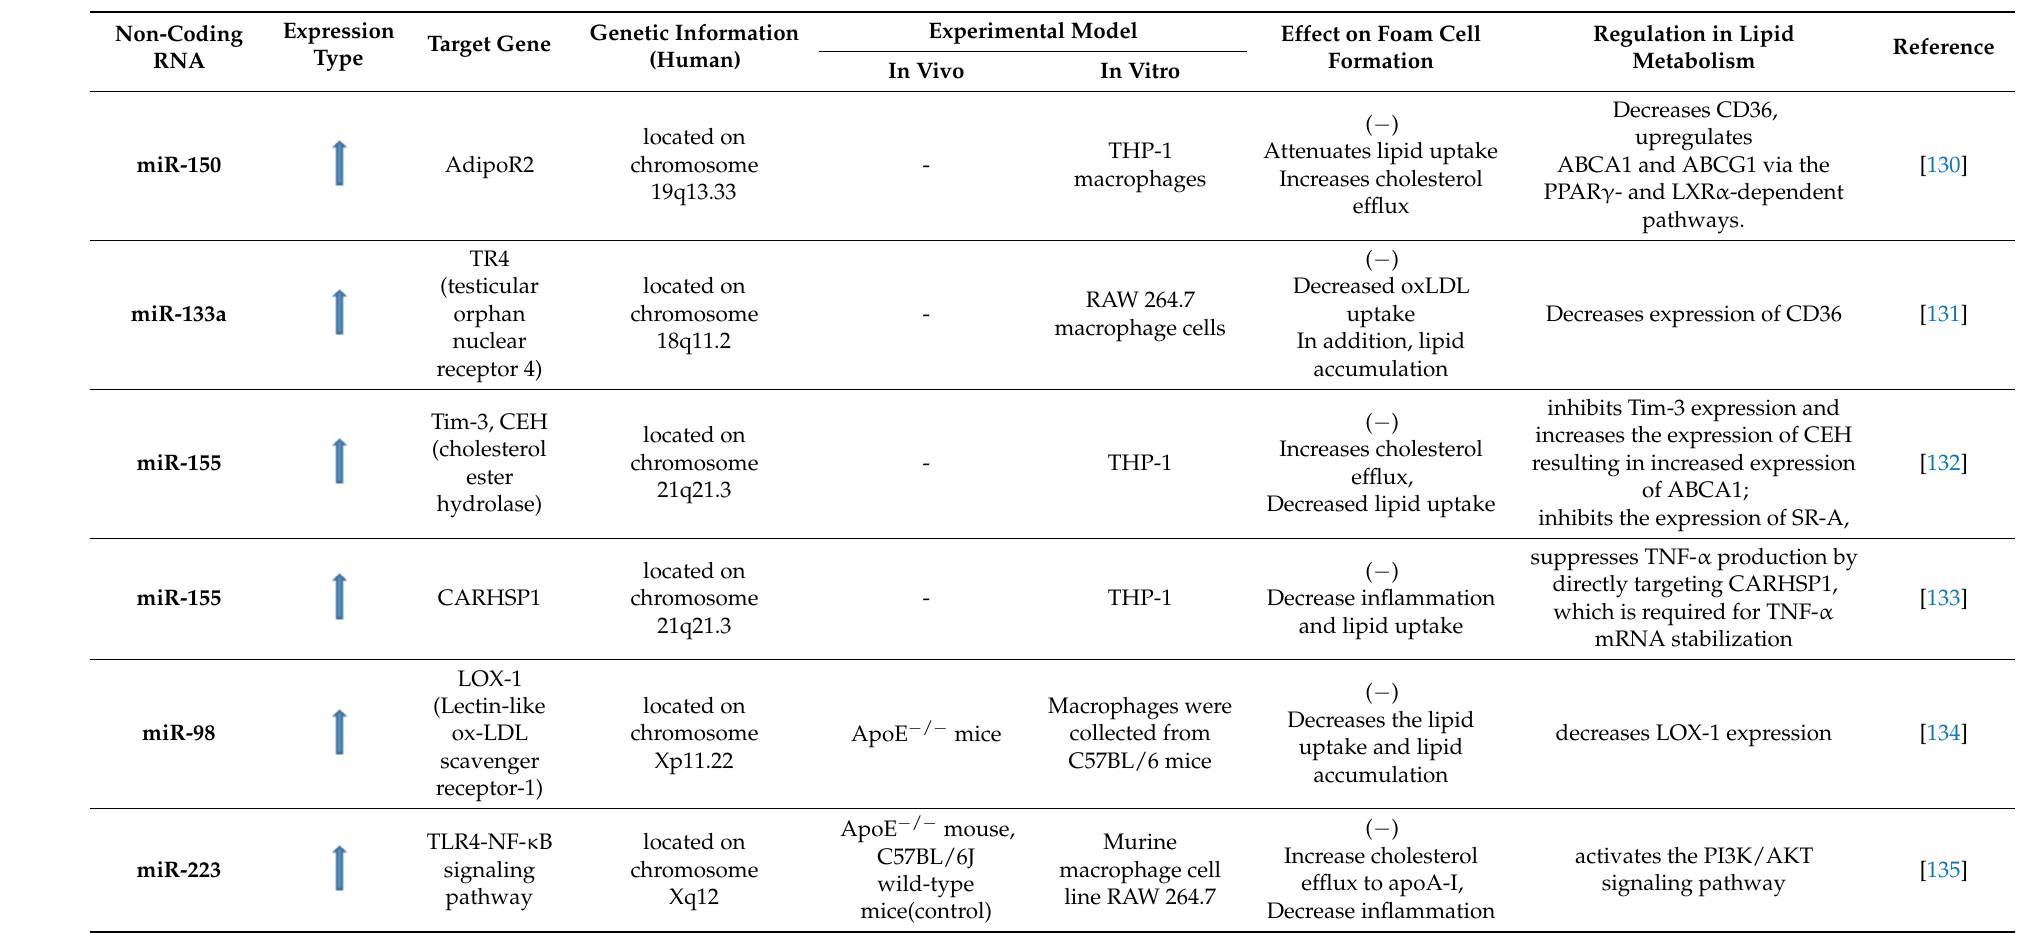
Table 1. Non-coding RNAs that stimulate foam cell formation/function. Table 2. Cont .